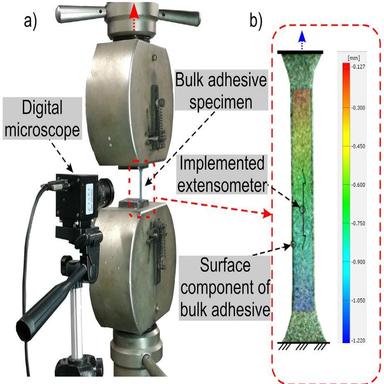
a) Quasi-static tensile test of bulk adhesive specimen; b) DIC as a strain measurement of bulk adhesive specimen.